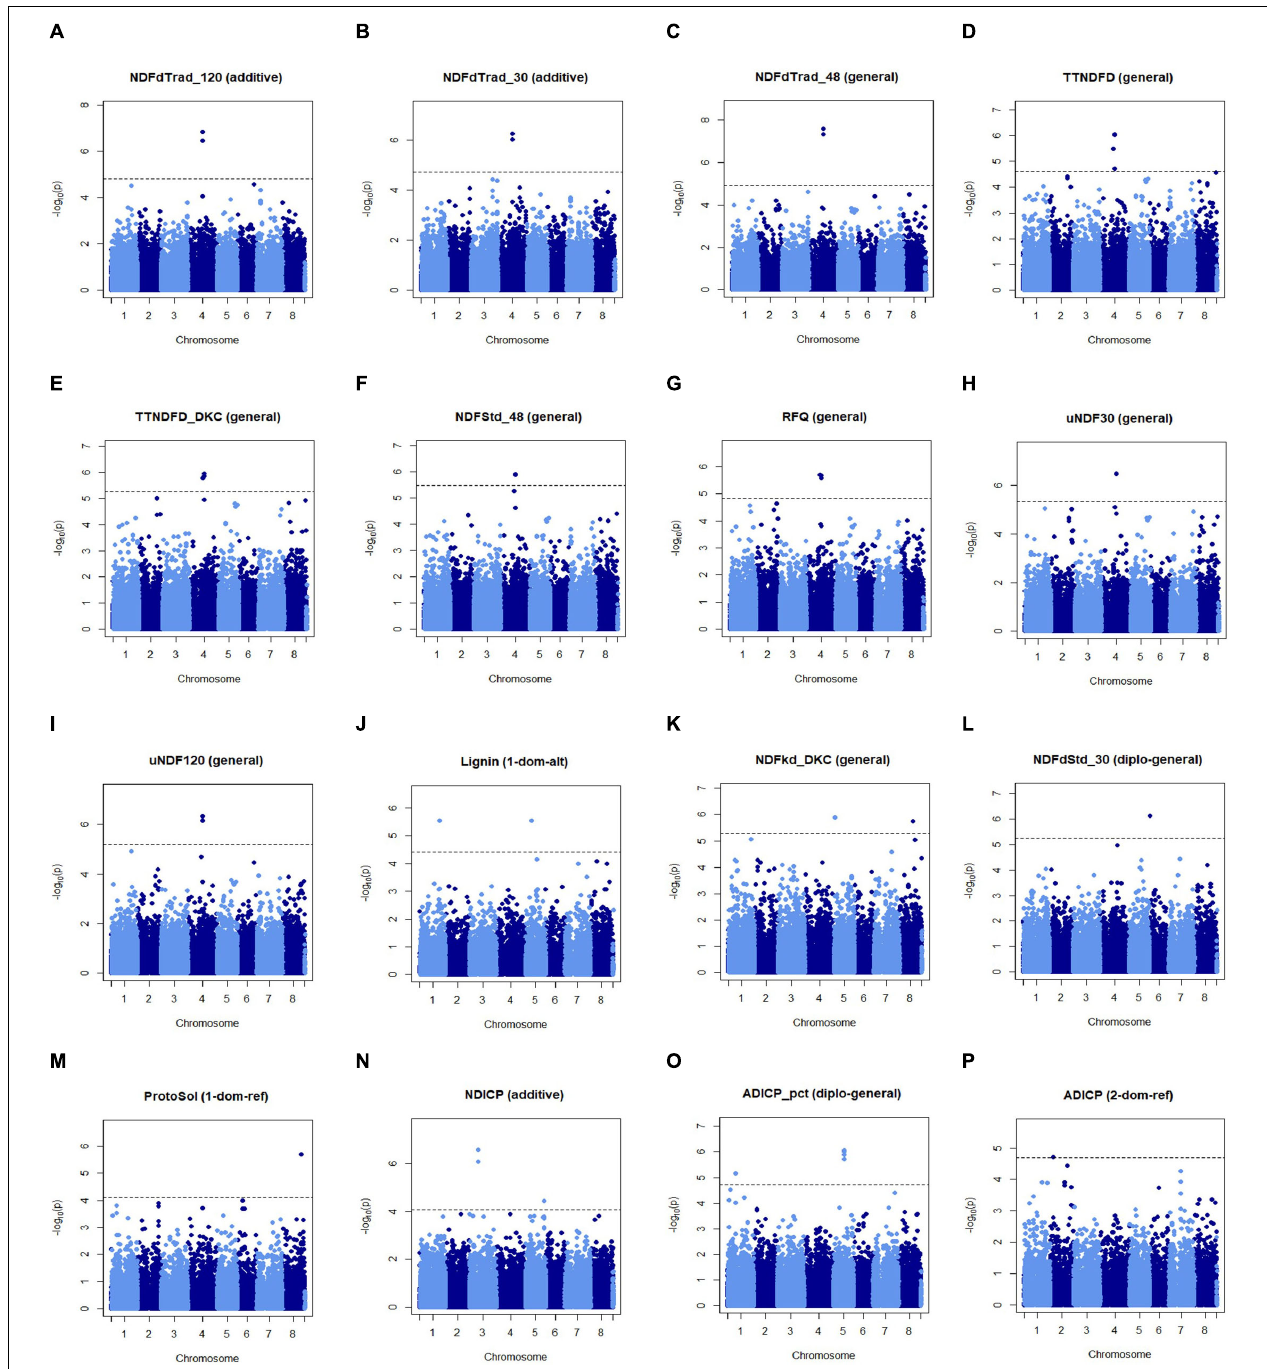
FIGURE 4 | Manhattan plots of marker-trait association of alfalfa quality traits. Significant markers were identified in multiple traits including NDFdTrad_120 (A) , NDFdTrad_30 (B) , NDFdTrad_48 (C) , TTNDFD (D) , TTNDFD_DKC (E) , NDFStd_48 (F) , RFQ (G) , uNDF30 (H) , uNDF120 (I) , Lignin (J) , NDFkd_DKC (K) , NDFdStd_30 (L) , ProtoSol (M) , NDICP (N) , ADICP_pct (O), and ADICP (P) . Chromosome positions were based on the genome of M. truncatula v5.0. X-axis shows the chromosome numbers, and Y-axis shows the -log p